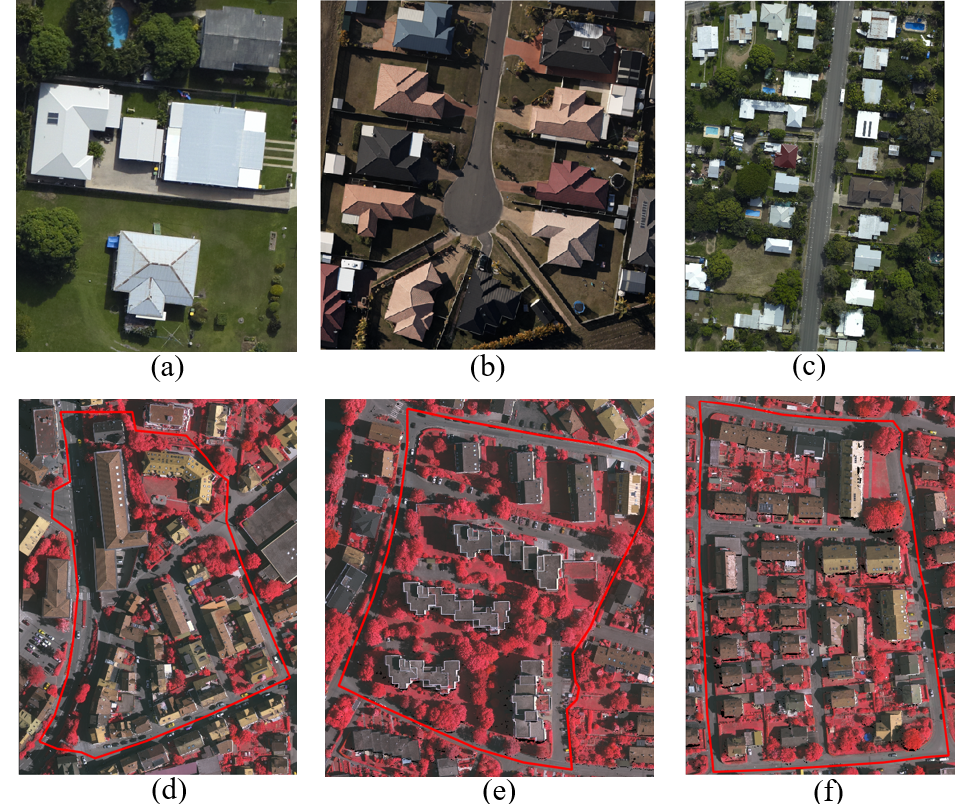
Figure 8. Used datasets for experiments. The first row shows the selected three sites from Australian datasets: ( a ) AV1, ( b ) HB, and ( c ) AV2. The second row indicates the three areas from the International Society for Photogrammetry and Remote Sensing (ISPRS) benchmark dataset: ( d ) VH1, ( e ) VH2 and ( f ) VH3. Buildings enclosed by the red line areas are taken into consideration for the ISPRS benchmark. It is hard to collect the ground truth from the point cloud data. Hence, we selected AV1 and VH3 only because these two sites are purely residential with detached